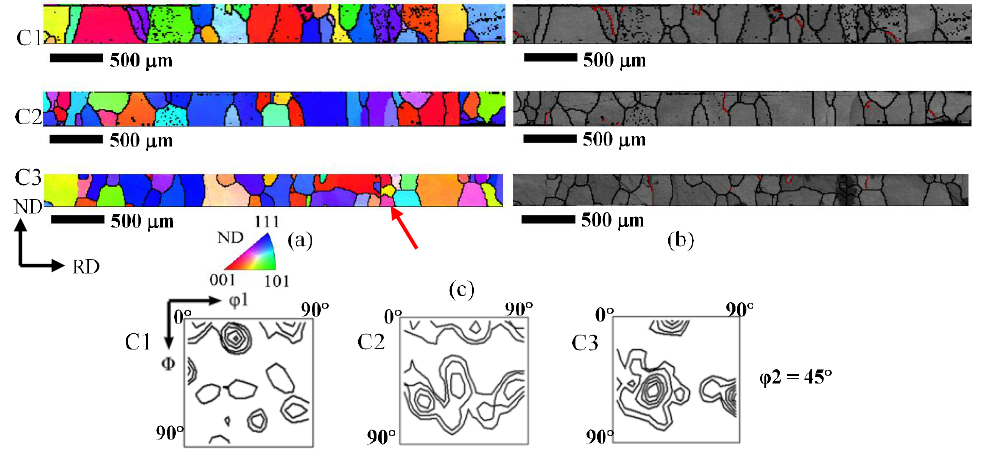
Figure 14. EBSD maps of 2# sheets after final transformation treatment under three conditions C1 to C3 of cold rolled 0.35 mm sheets from hot-rolled bands. ( a ) IPF-ND maps; ( b ) band contrast maps (red lines: Σ3); ( c ) ODFs at ϕ 2 = 45° section. Red arrow in ( a ) indicates a small region of two-layer grains in C3-processed sheet.